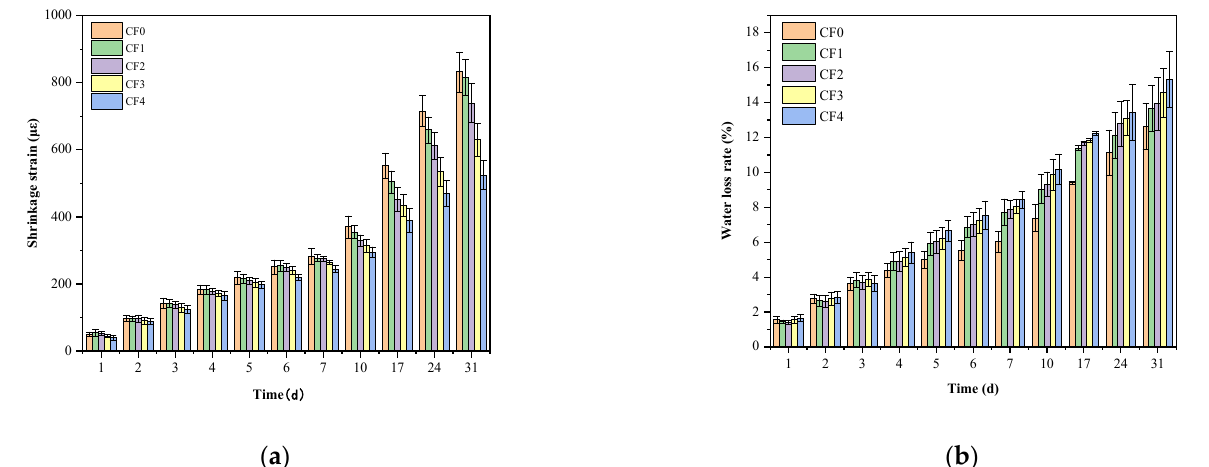
Figure 5. Changes in ( a ) shrinkage strain and ( b ) water loss rate of CSM with 100% RMA over time under different fly ash replacement rates.